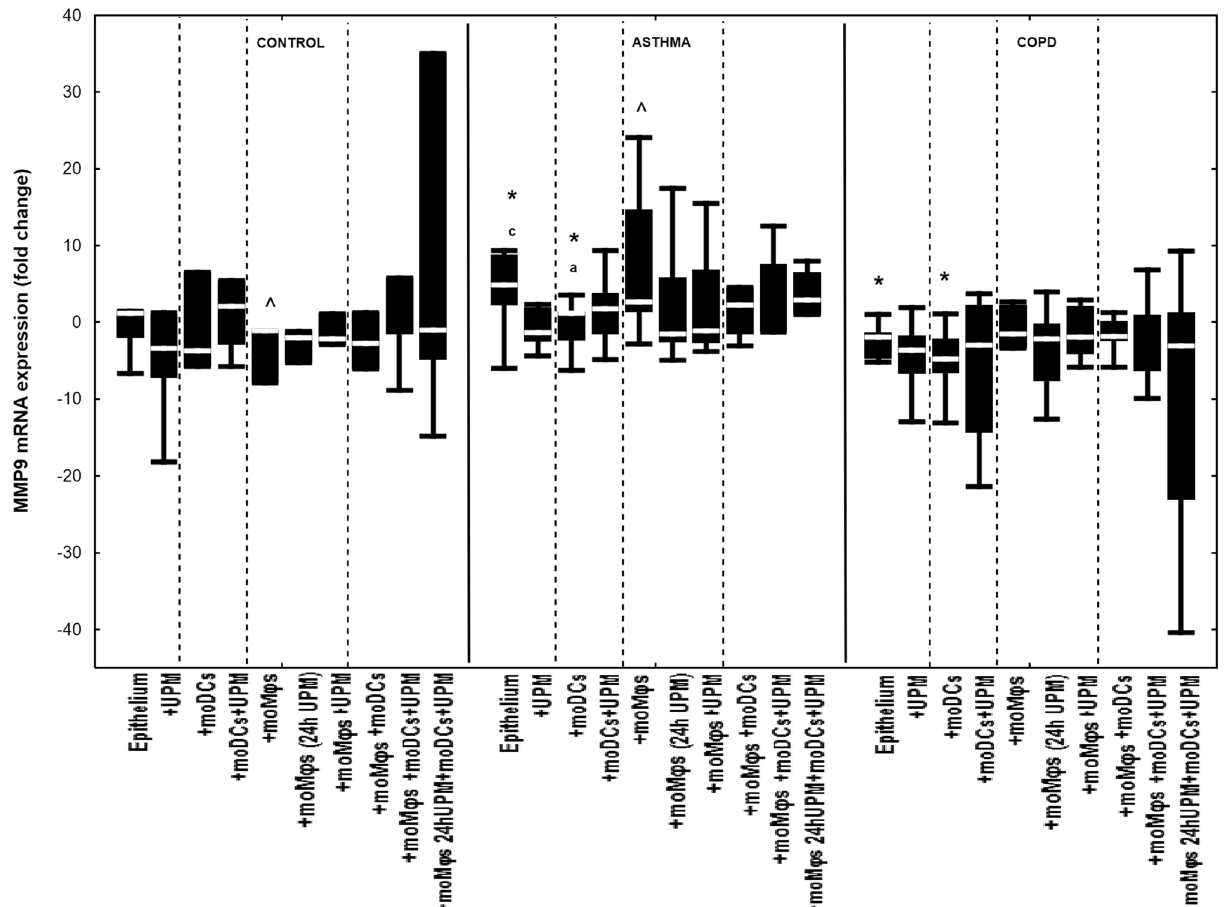
Figure 6. MMP9 mRNA expression in air–liquid interface (ALI) after 24 h UPM exposure in multi co-culture schemes in control subjects, asthma and COPD patients. The data are shown as non-outlier range (whiskers), interquartile range (box) and median (line); p value calculated using Mann–Whitney U test. The p value < 0.05 in comparison to: a—epithelium, b—epithelium + UPM, c—epithelium + moDCs, d—epithelium + moDCs + UPM, e—epithelium + moMφs, f—epithelium + moMφs (24 h UPM), g— epithelium + moMφs + UPM, h—epithelium + moMφs + moDCs, i—epithelium + moMφs + moDCs + UPM, j—epithelium + moMφs (24hUMP) + moDCs + UPM; ^ asthma versus control, # COPD versus control, *asthma versus